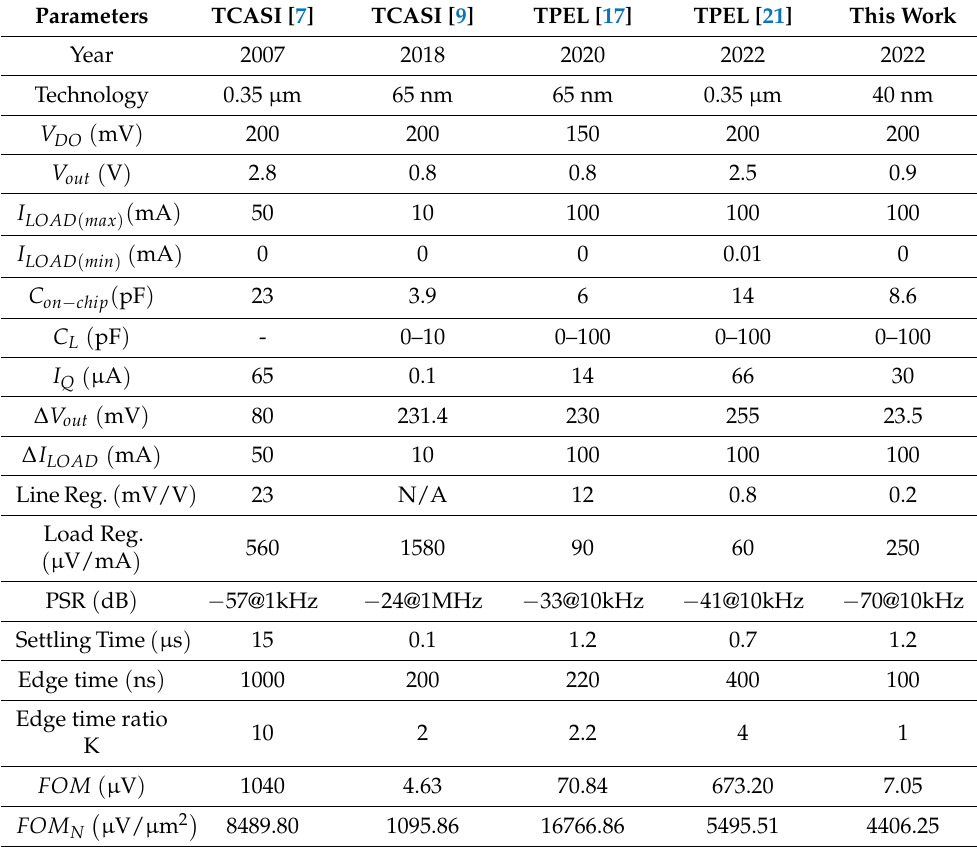
Table 2. Performance comparison with prior-reported OCL-LDO